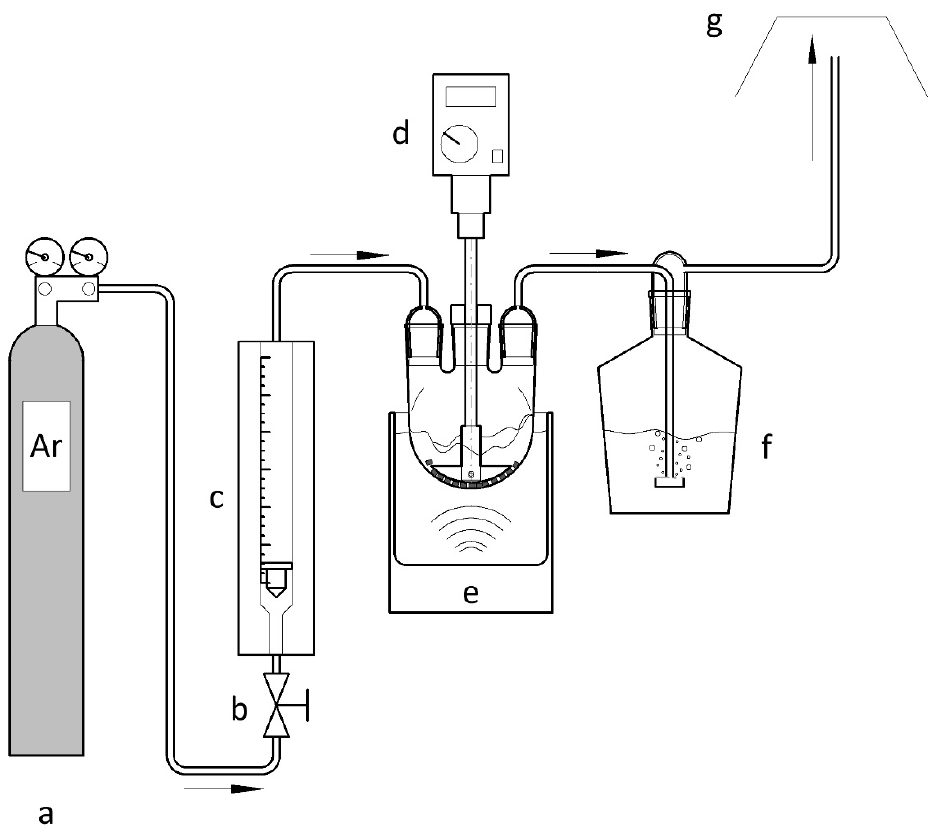
Figure 5. Innovative experimental set-up for leaching of PCD samples where: a—argon, b—valve; c—flow meter; d—mixer, e—reactor, f—bottle with dissolved sodium hydroxide, e—exhaust system.